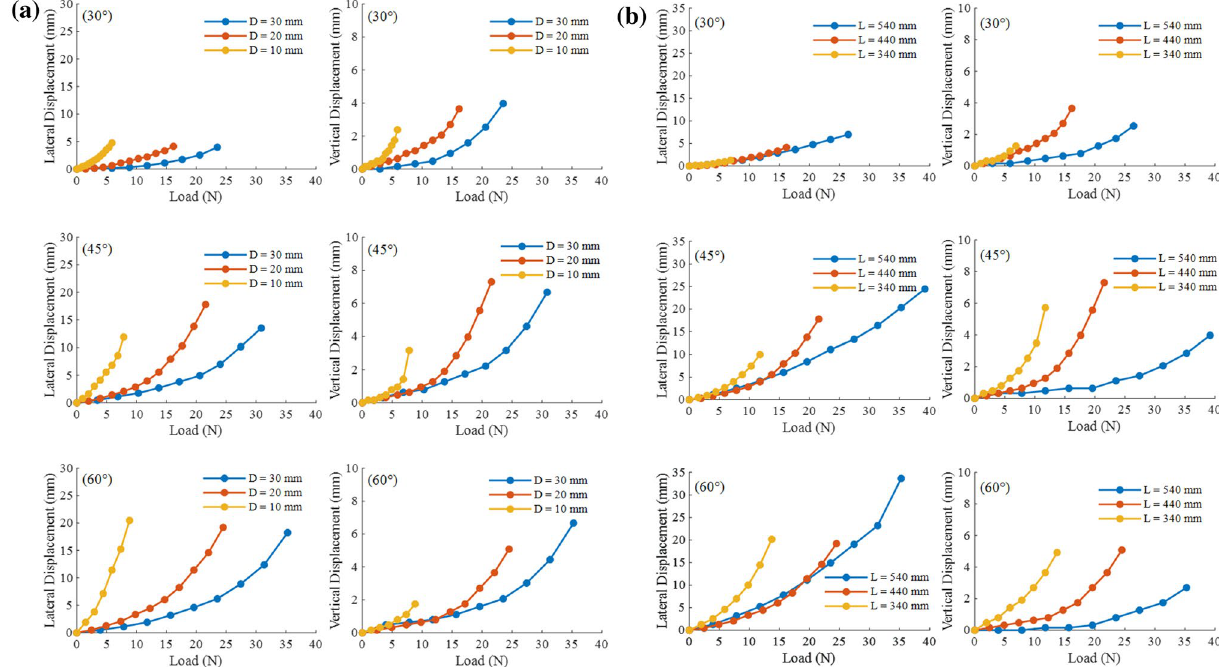
Figure 7. Lateral and vertical displacement–load curve of circular single pile’s with variables in pile diameter ( a ) and embedded depth ( b